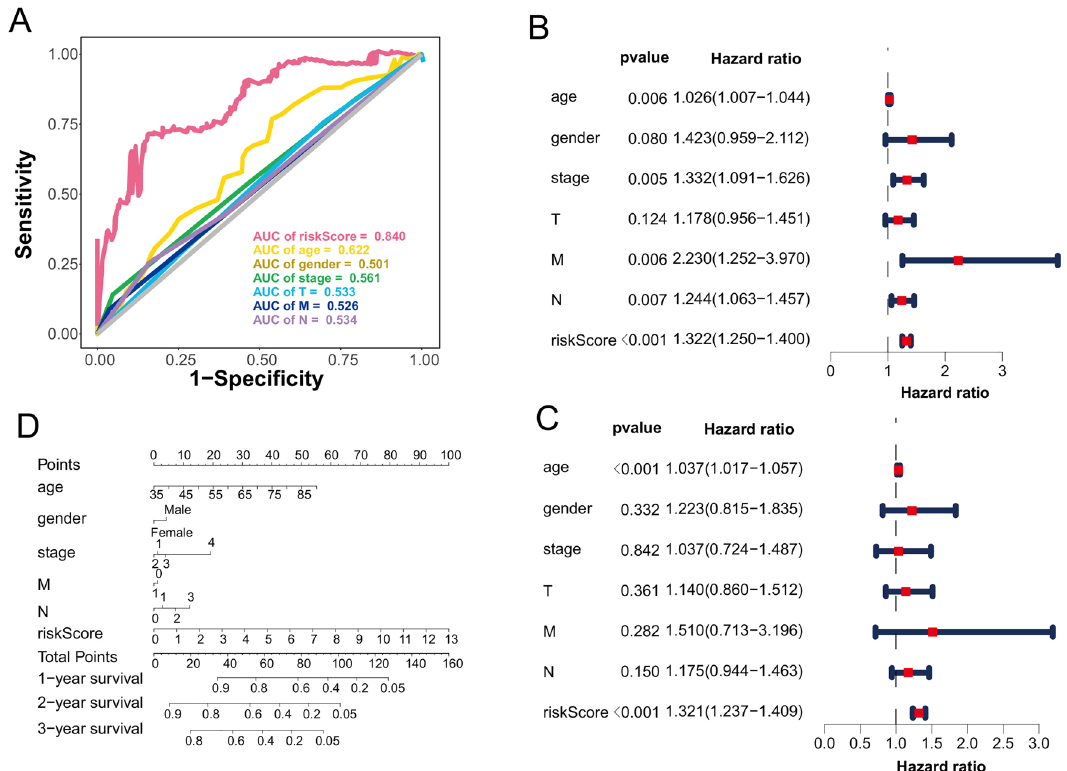
Figure 4. Identified the clinical value of risk score. ( A ) The AUC value of risk score and other clinical factors. The table shows the HR of risk score and other clinical factors calculated by univariate Cox regression ( B ) and multivariate Cox regression ( C ). ( D ) The nomogram constructed by different clinical factors in STAD